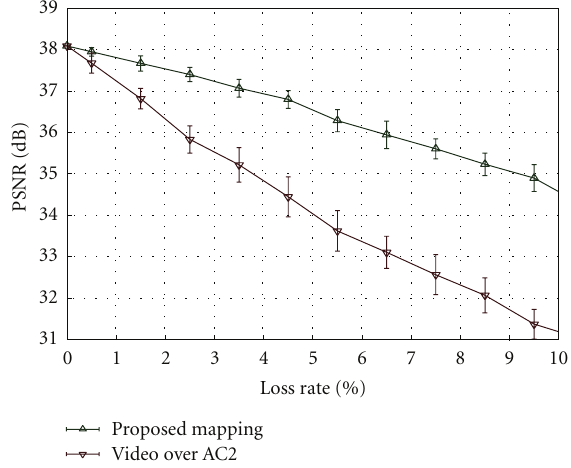
Figure 6: Mean Y-PSNR for the Paris video sequence for the simulated network scenario.